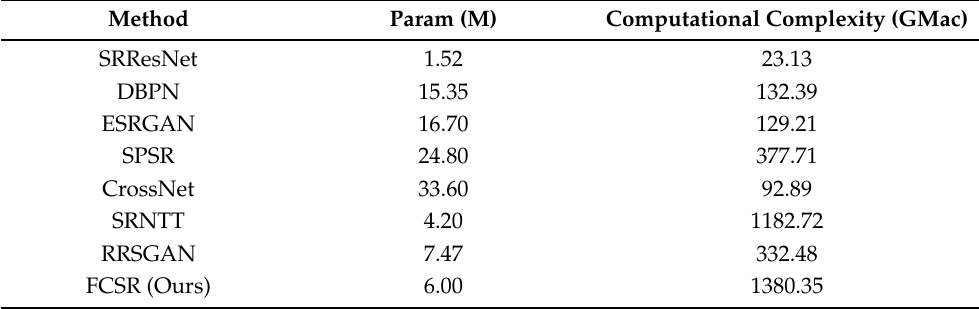
Figure 9. Visual comparison between FCSR-rec and the proposed method of ×4 factor on diverse test sets. FCSR-rec denotes only using reconstruction loss when training FCSR. We enlarge the image details inside the light red rectangle and show in the red rectangle in the upper right corner. Table 7. Comparison of model parameters, computational complexity, and training time. SRResNet, DBPN, ESRGAN, and SPSR are super-resolution image reconstruction methods without reference images. CrossNet, SRNTT, RRSGAN, and FCSR are RefSR methods. Partial results of comparison methods originate from